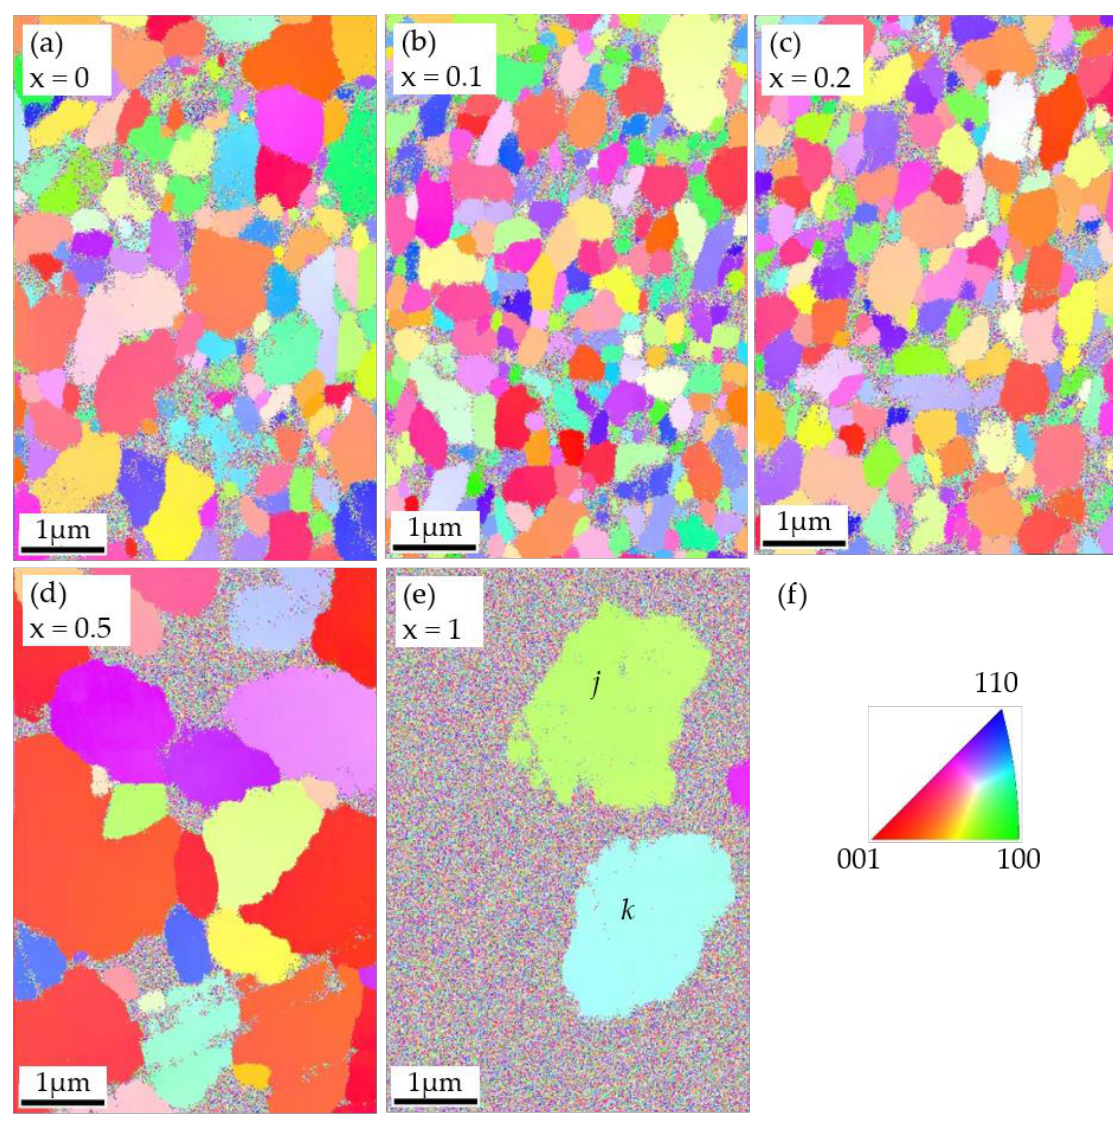
Figure 2. Electron backscatter diffraction (EBSD) inverse pole figure map of C x S 1–x BT layer in the FeFET stacks with ( a ) x = 0; ( b ) x = 0.1; ( c ) x = 0.2; ( d ) x = 0.5; and ( e ) x = 1. ( f ) Color coded unit triangle.